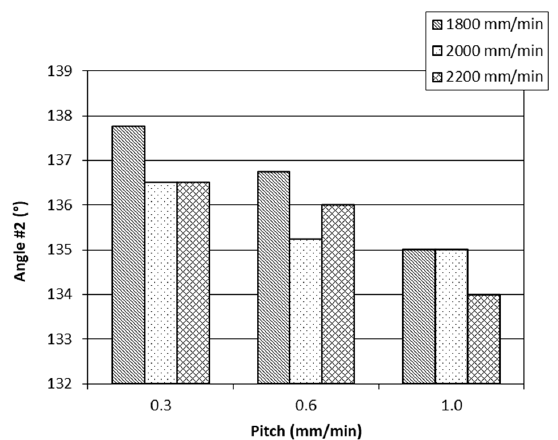
Figure 6. Experimental angle #2 obtained for different pitches and feed-rates.